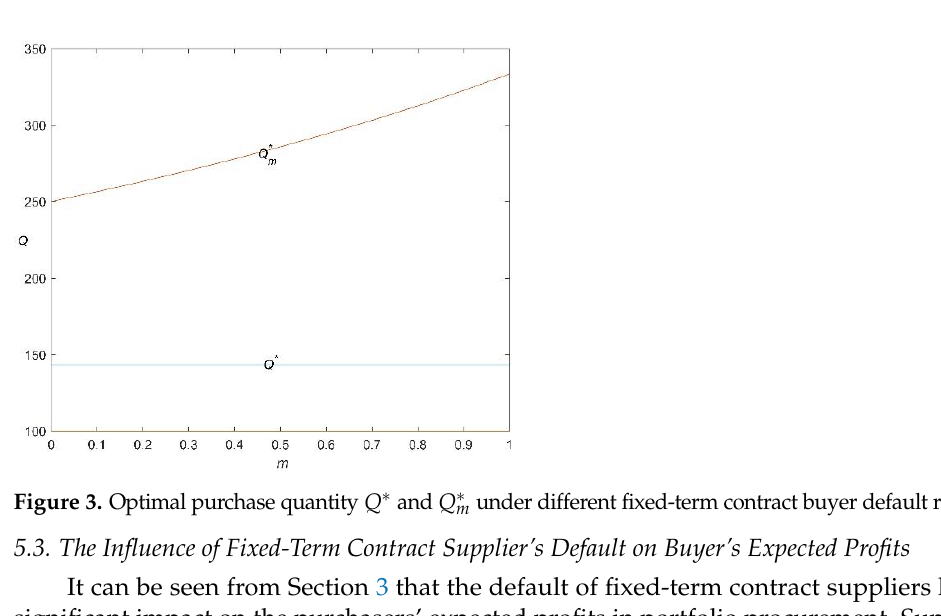
* Q * Q and under different fixed-term contract buyer default m